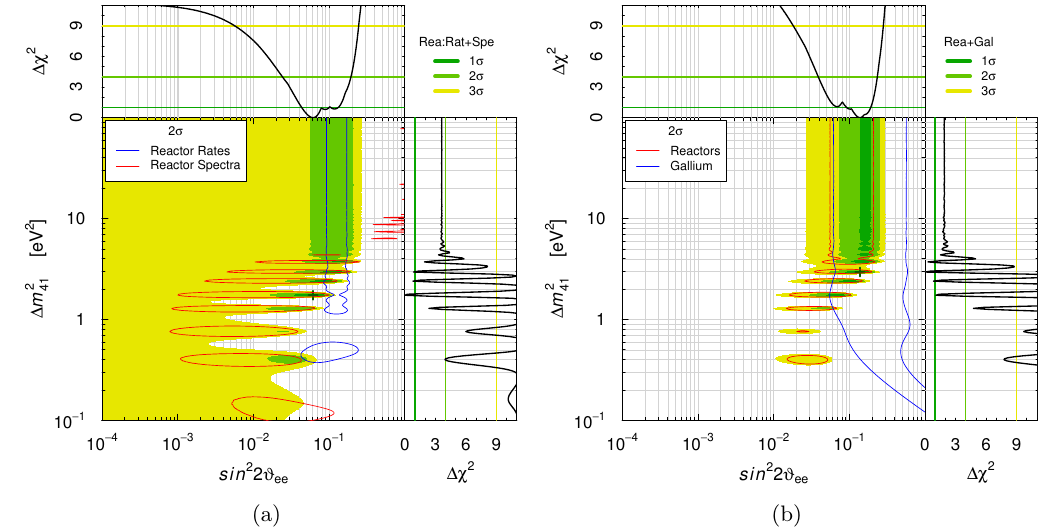
Figure 3 . Allowed regions in the sin 2 2 # ee {(cid:1) m 2 obtained from: (a) the combined (cid:12)t of the rate and spectral data of reactor antineutrino experiments; (b) the combined (cid:12)t of the reactor and Gallium data. The best-(cid:12)t points corresponding to (cid:31) 2 table 4 are indicated by